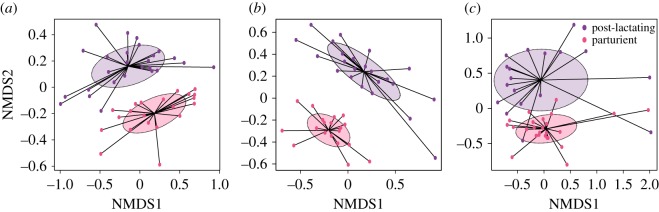
Shift of microbiota composition in reproductive females of M. natalensis in (a) saliva, (b) faeces and (c) urine. Each data point represents the microbiota from one bat. Shaded ellipses represent standard deviation around sample group centroids. Parturient and post-lactating females are denoted by different colours.